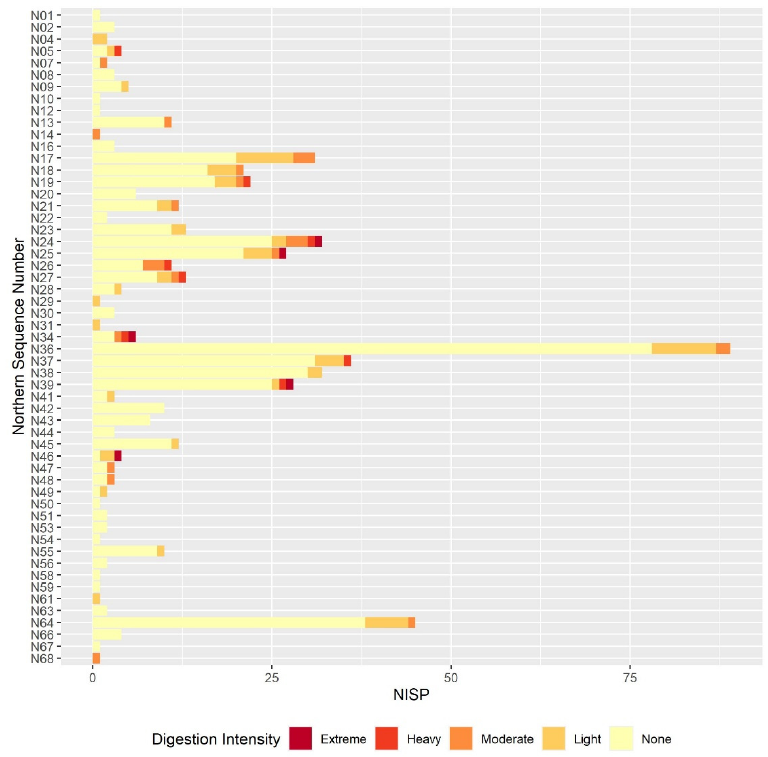
Figure 6. Observed isolated molar digestion intensities in the northern sequence. NISP: number of identifiable specimens.